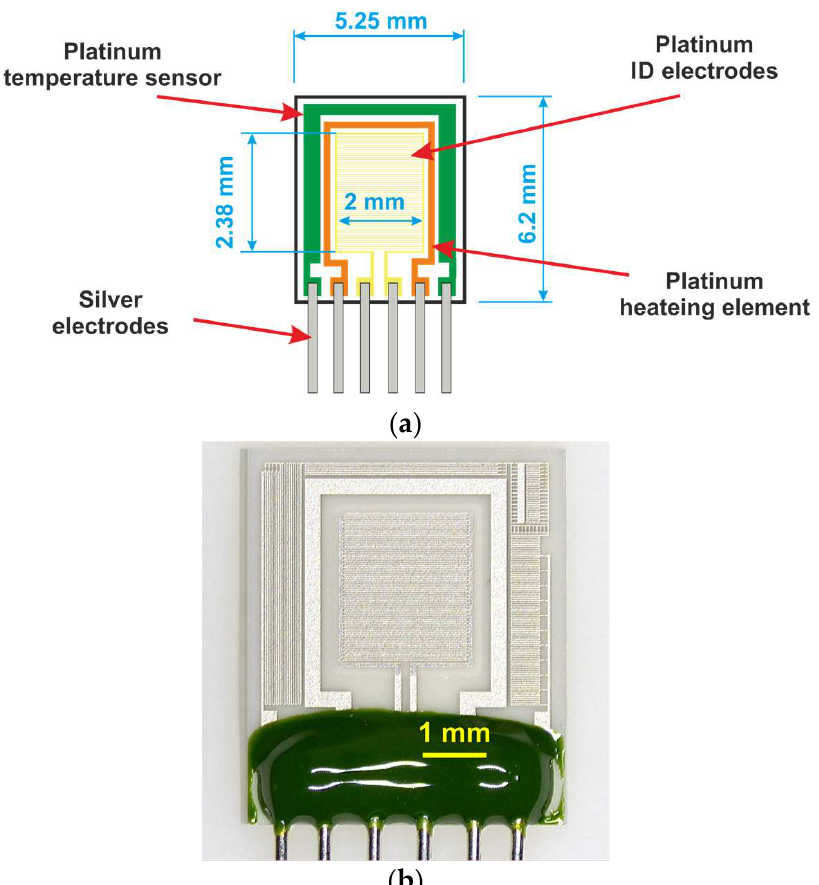
Figure 1. Sensor platform KBI2 Tesla Blatná: ( a ) the schematic diagram with dimensions, ( b ) sensor platform without a sensitive layer.